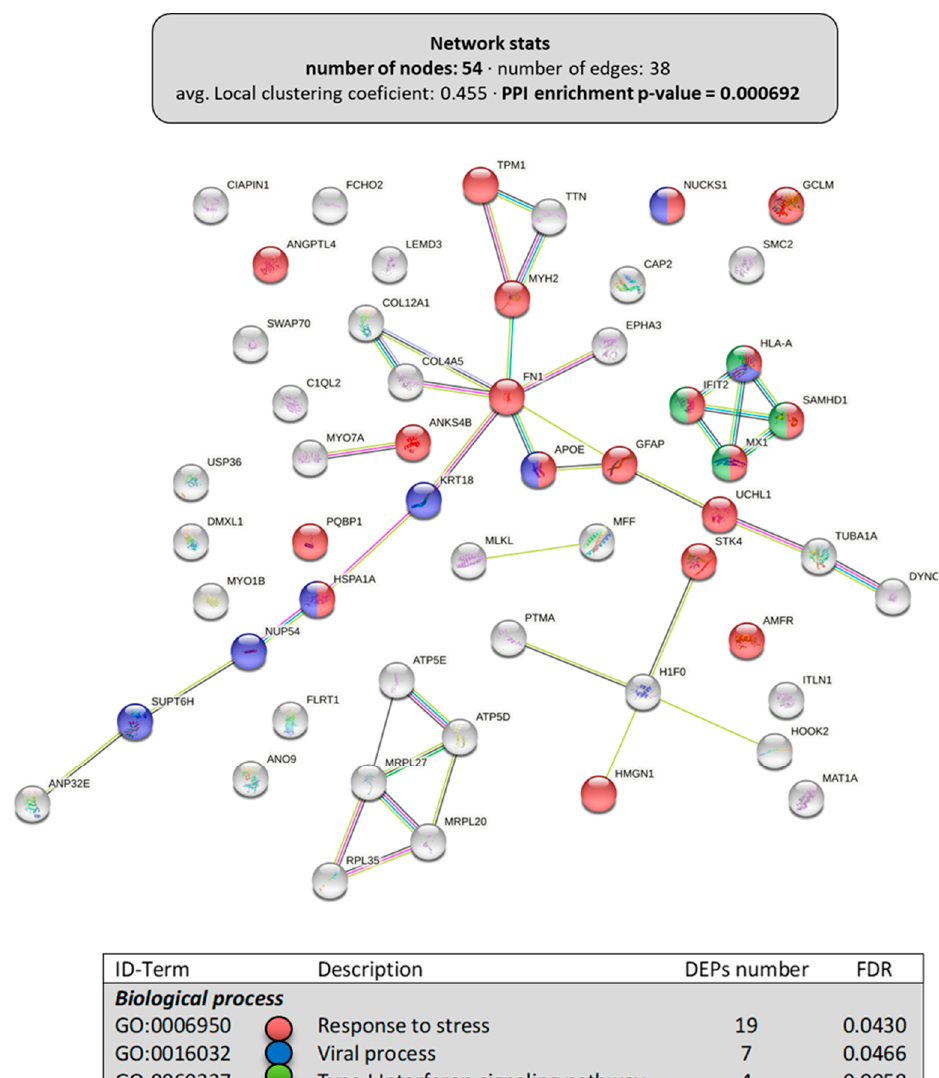
Figure 5. Specific network of the downregulated DEPs in the intestine of LPL-fed salmon. Analyses of putative clusters related to “cellular component organization” of the downregulated DEPs (Figure 3). Each node represents one differentially expressed protein (DEP) obtained from intestine shotgun proteomics. Details on the functional network statistics (network stats) are indicated ( top ). The selected relevant biological processes ( bottom ) are presented with the corresponding colors in each node.